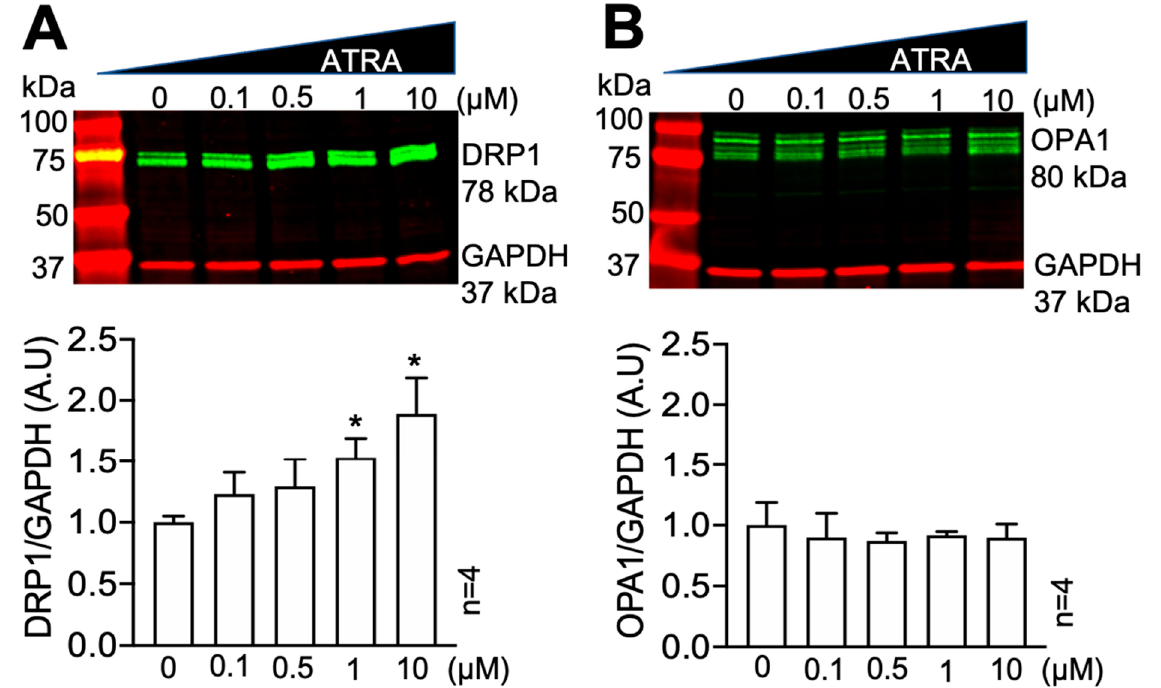
Figure 1. Dose-dependent effect of ATRA on DRP1 and OPA1. Western blot of DRP1 protein levels in HEK293 cells incubated with 0.1, 0.5, 1, and 10 µM ATRA for 24 h, normalized to the levels of DMSO controls (0 µM). ( A ) ATRA increased the levels of DRP1 in a dose-dependent manner (* p < 0.05, 1, and 10 µM ATRA vs. DMSO control (0 µM); One sample t - and Wilcoxon-test). ( B ) ATRA did not affect OPA1 levels.